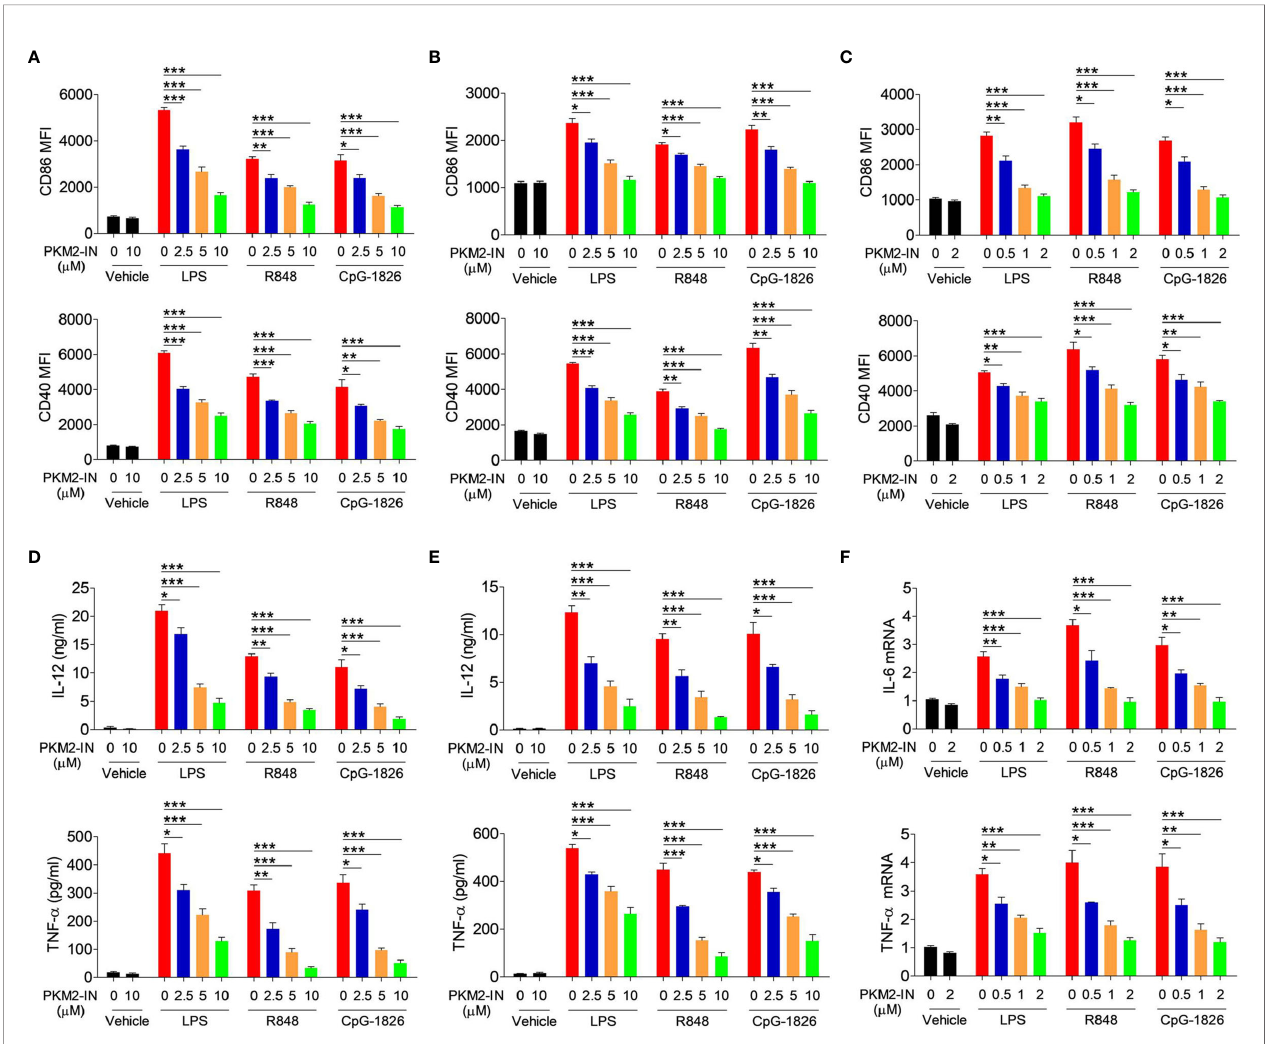
FIGURE 3 | Pharmaceutical inhibition of PKM2 inhibits TLRs-induced activations of BMDMs, BMDCs and murine splenic B cells. BMDMs, BMDCs and murine splenic B cells were pretreated with PKM2 inhibitor PKM2-IN (2.5, 5 and 10 m M) for 2 hours followed by stimulations of LPS (100 ng/mL), R848 (1 m g/mL) and CpG- 1826 (1 m M). FACS analysis of CD86 and CD40 expressions on BMDMs (A) , BMDCs (B) and murine splenic B cells (C) at 24 hours. ELISA analysis of the levels of IL-12 and TNF- a secreted by BMDMs (D) and BMDCs (E) at 24 hours. Q-PCR analysis of the mRNA levels of IL-6 and TNF- a on murine splenic B cells at 6 hours. The data shown represent the means of three independent experiments and the error bars represent the S.E.M. * p < 0.05, ** p < 0.01, *** p < 0.001, as determined by ANOVA